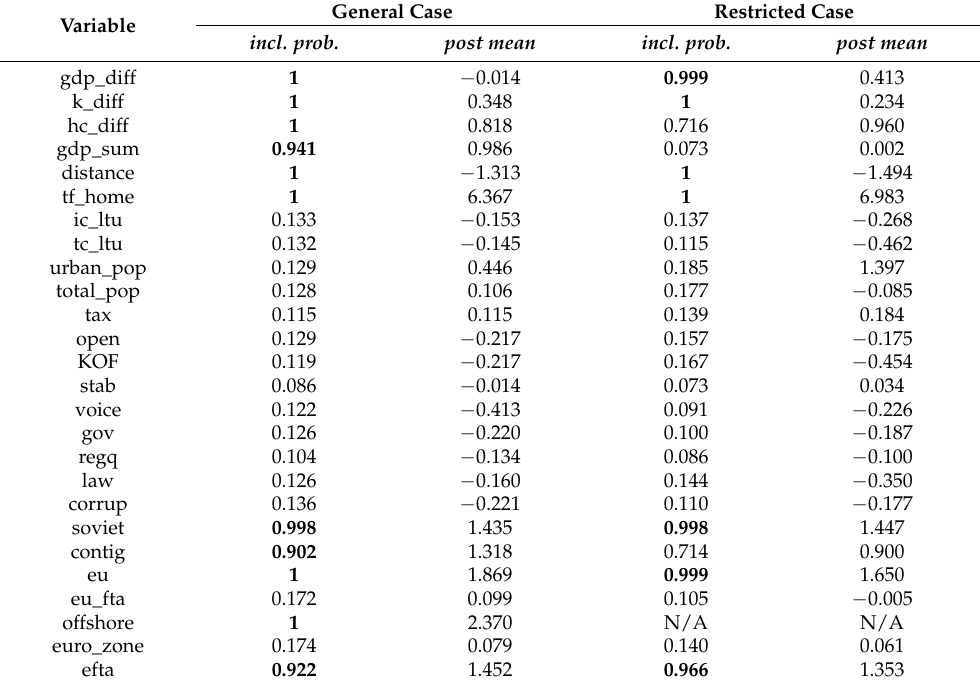
Table A7. Determinants of inward FDI in Lithuania